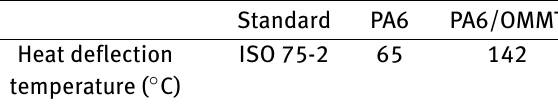
Table 2: HDT of PA6/OMMT nanocomposites Standard PA6 PA6/OMMT Heat deflection temperature ( ∘